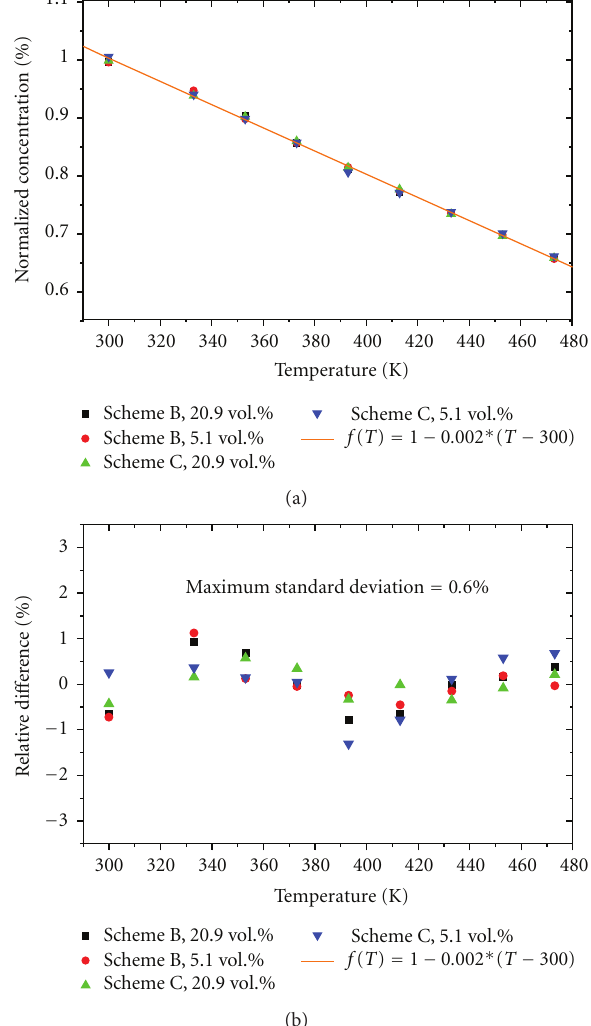
F 7: (Color online) combination of the normalized measure- ment results of scheme B and